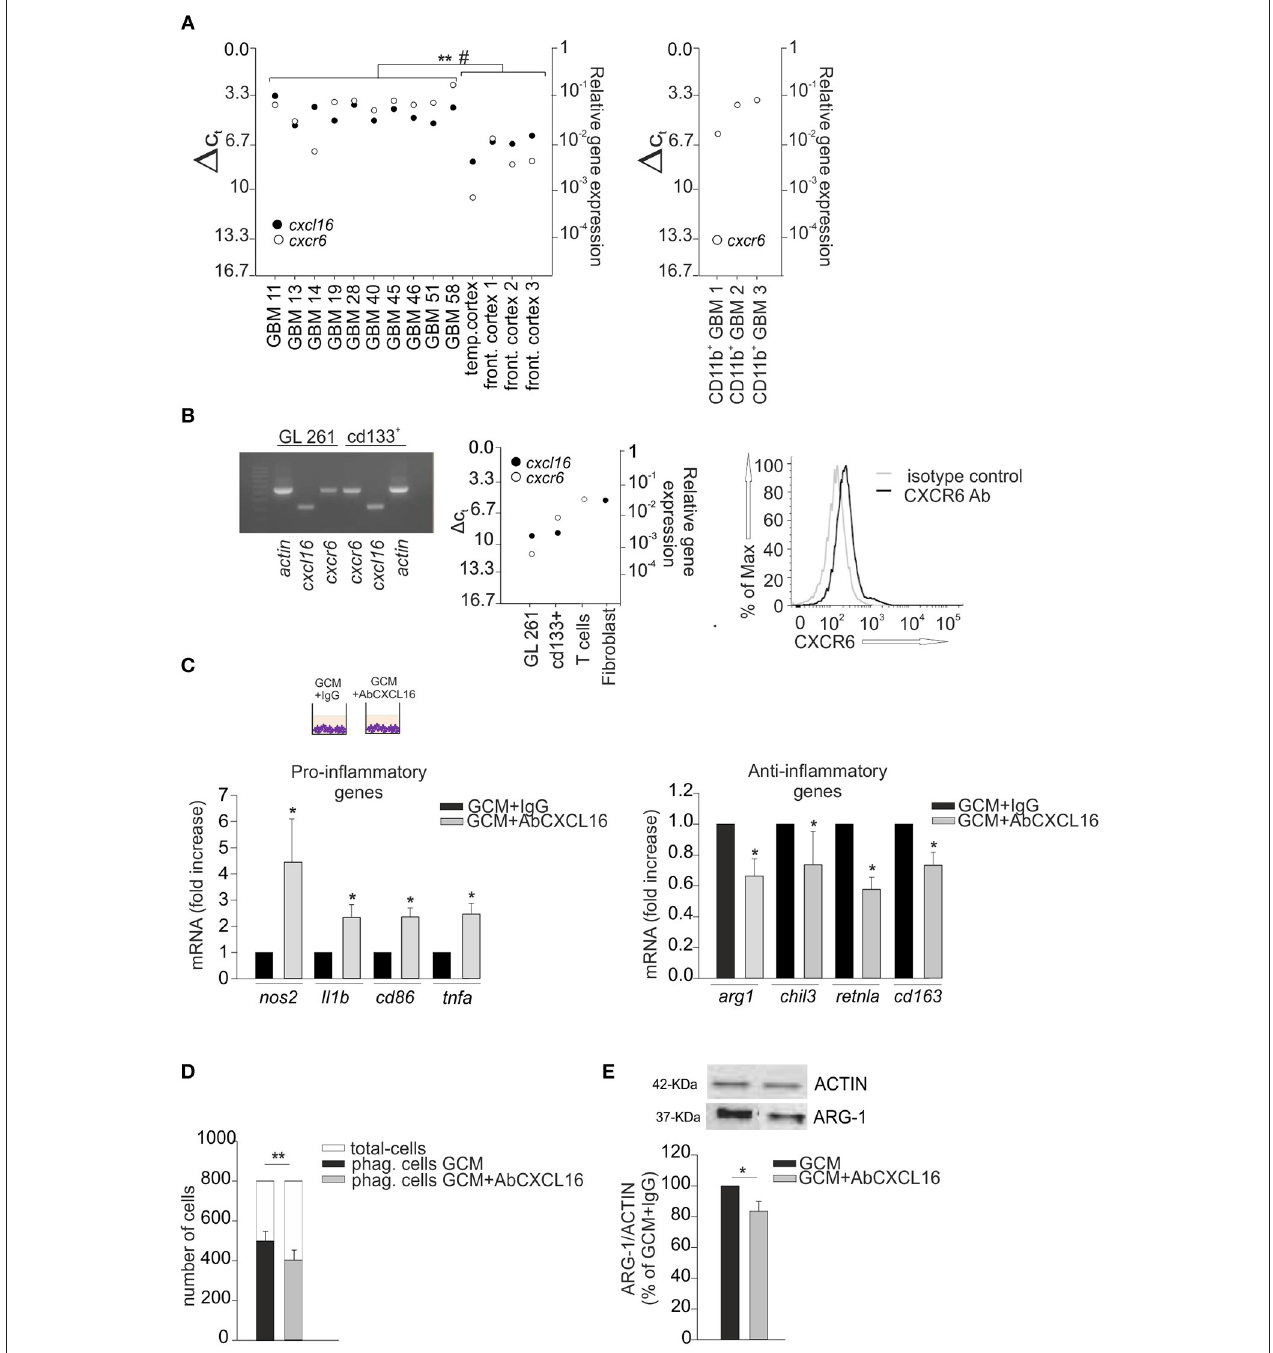
FIGURE 2 | CXCL16 released by glioma cells modulates microglia phenotype. (A) Left panel, RT-qPCR for cxcl16 and cxcr6 (black and white circles) mRNA expression in human GBM tissues and in human control tissues (temporal or frontal cortex); right panel, qRT-PCR for cxcr6 mRNA expression in human CD11b + cells (microglia/machrophages) isolated by GBM tissues. Mean values of double measurements from individual patients; 1 CT values = CT gene of interest—CT gapdh (housekeeping gene). A 1 CT of 3.33 corresponds to one magnitude lower gene expression compared to gapd h; (B) Left panel, representative PCR for cxcl16 , cxcr6 , and actin mRNAs expression in mouse GL261 cells and mouse GL261 derived stem cells (cd133 + ); right panel RT-qPCR for cxcl16 and cxcr6 (black and white circles) mRNAs expression in GL261, cd133 + cells, and in mouse T-cells and fibroblasts; CXCR6 surface expression on mouse GL261 cells as evaluated by flow cytometry. Black and gray lines represent CXCR6 staining and isotype control, respectively. (C) Expression analysis by RT-qPCR for mRNAs of pro-inflammatory related genes ( nos2, il1b, cd86, tnfa ) (left panel), or anti-inflammatory related genes (a rg1, chil3, retnla, cd163 ) (right panel) in primary wt microglia treated with GCM in the presence of AbCXCL16 neutralizing antibody (GCM + AbCXCL16) or control IgG (GCM + IgG). For each gene data are expressed as specific mRNA fold change